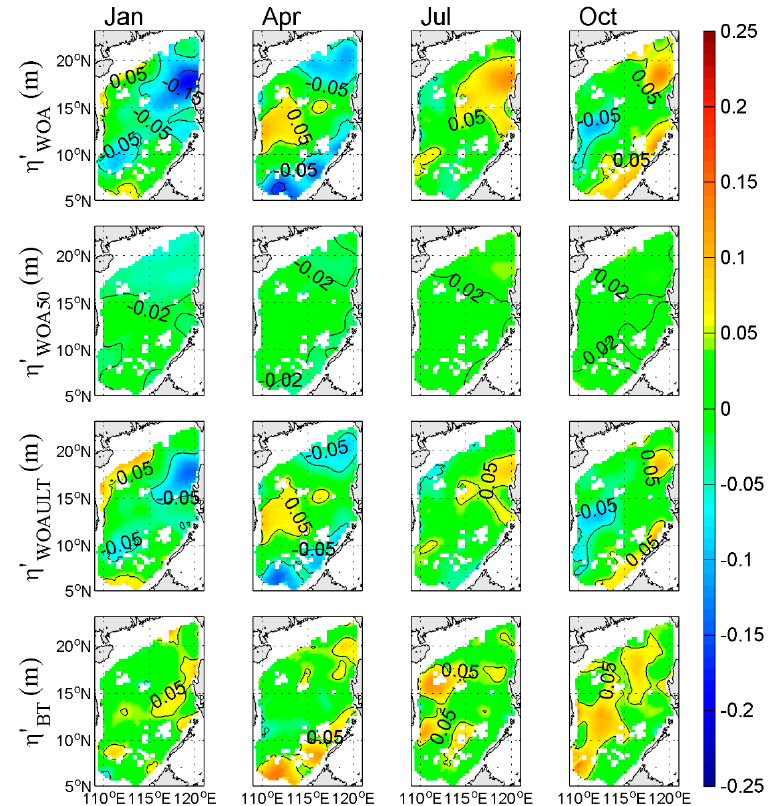
 and η (cid:48) . Figure 11. Seasonal variability of η BT